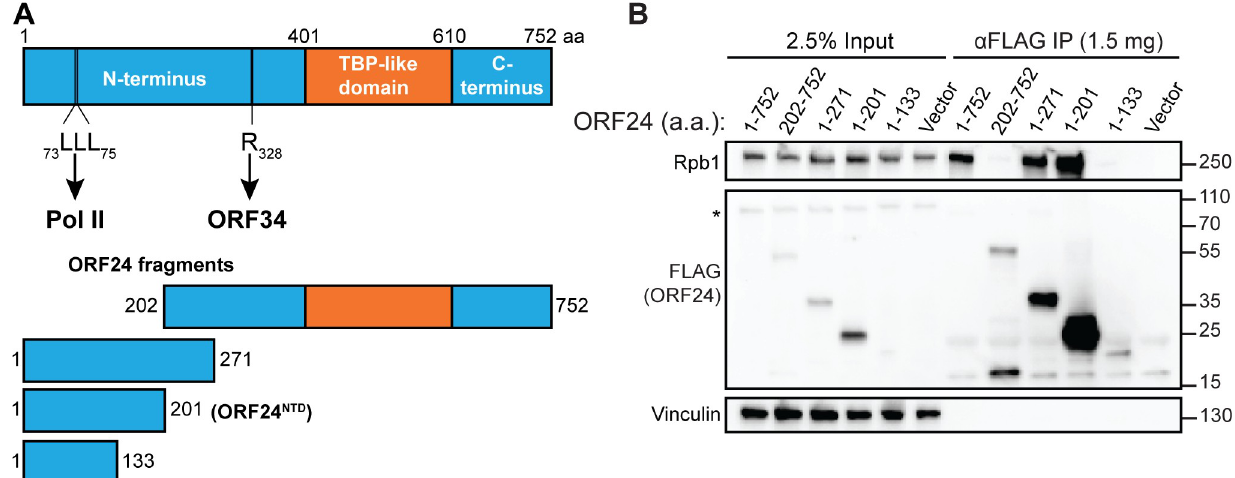
Fig 2. The N-terminal domain of ORF24 (ORF24-NTD) binds Pol II. (A) Schematic of constructs used to identify a minimal N-terminal domain of ORF24 showing the predicted boundaries for the N-terminal domain, the TBP-like domain, and the C-terminal domain, including residues known to be required for Pol II binding (amino acids 73–75) and interaction with ORF34 (amino acid 328). (B) HEK293T cells were transiently transfected with full- length or truncated FLAG-tagged ORF24 and co-immunoprecipitated (IP) with anti-FLAG beads followed by western blotting with the indicated antibodies to detect ORF24 and Pol II. ( � ) indicates the presence of a non-specific band seen while using the anti-Strep antibody.